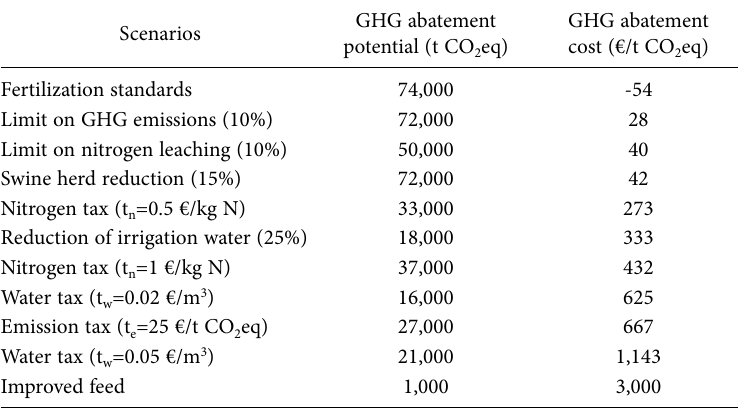
Table 6. GHG abatement potential and cost of